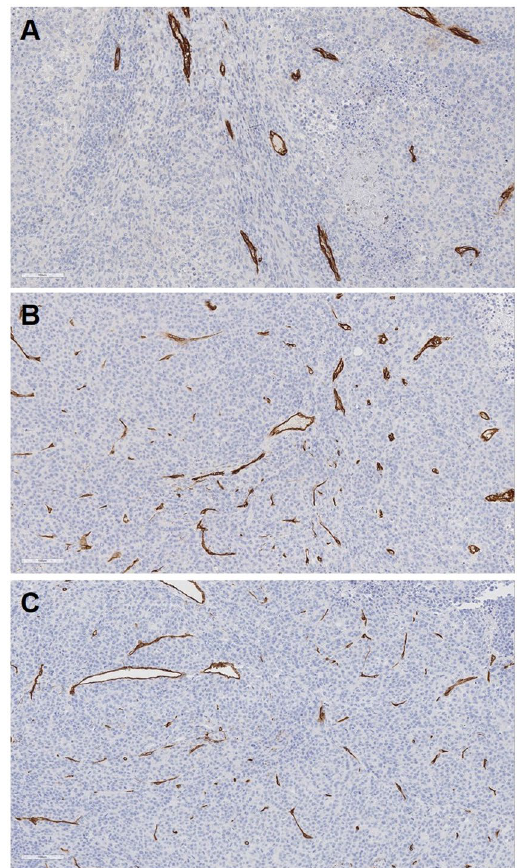
Figure 7. CD34 immunohistochemical staining of liver tissues treated by oral administration of SOF solution ( A ), IA administration of SOF/TIBA/PLGA20 MSs ( B ), and IA administration of TIBA/PLGA MSs ( C ),